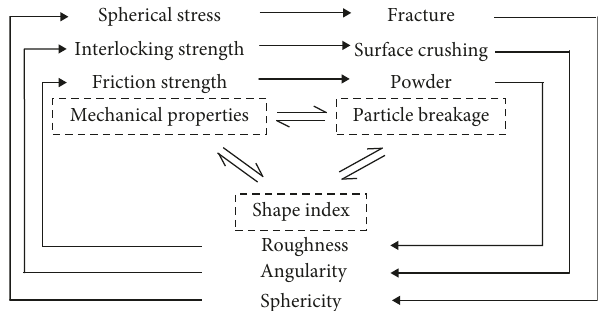
Figure 3: Relationships among particle breakage, shape index, and mechanical